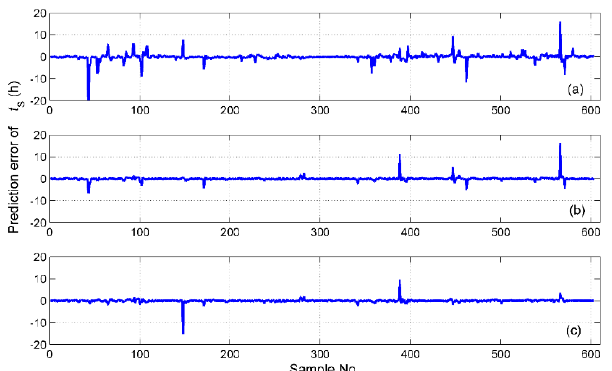
Figure 17. The prediction errors of 𝑡 𝑠 for the different fusion schemes, namely: ( a ) feature level data fusion; ( b ) decision level data fusion; ( c ) hybrid multi-sensor data fusion.